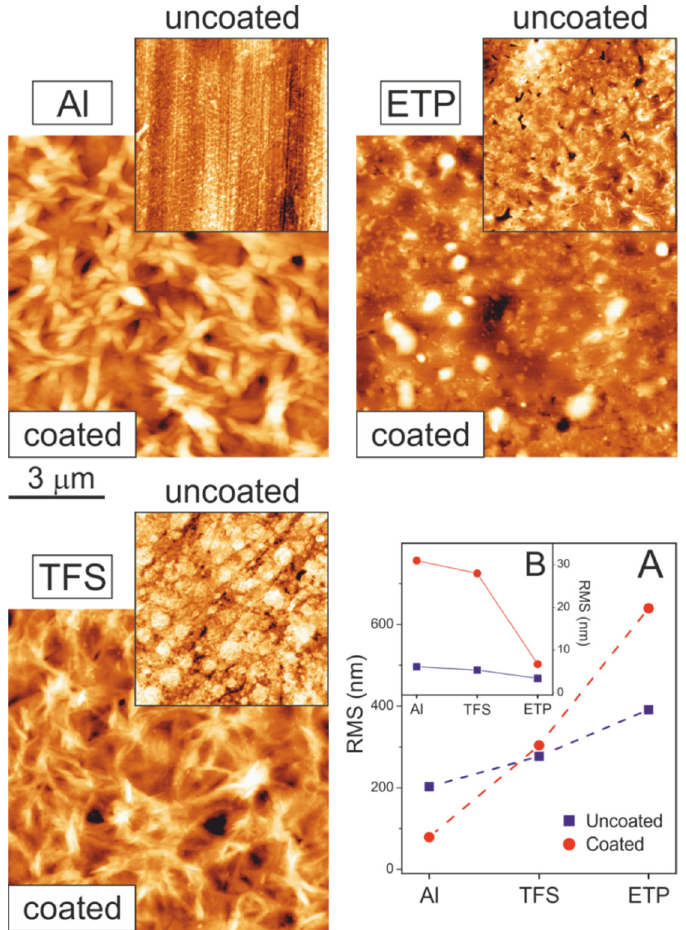
Figure 2. Small range AFM topographic images of bare and polyaleuritate-coated Al, TFS and ETP substrates. The scale bar is applicable to all images. The plot shows the evolution of surface roughness (RMS) obtained from large ( A ) and small ( B ) range AFM